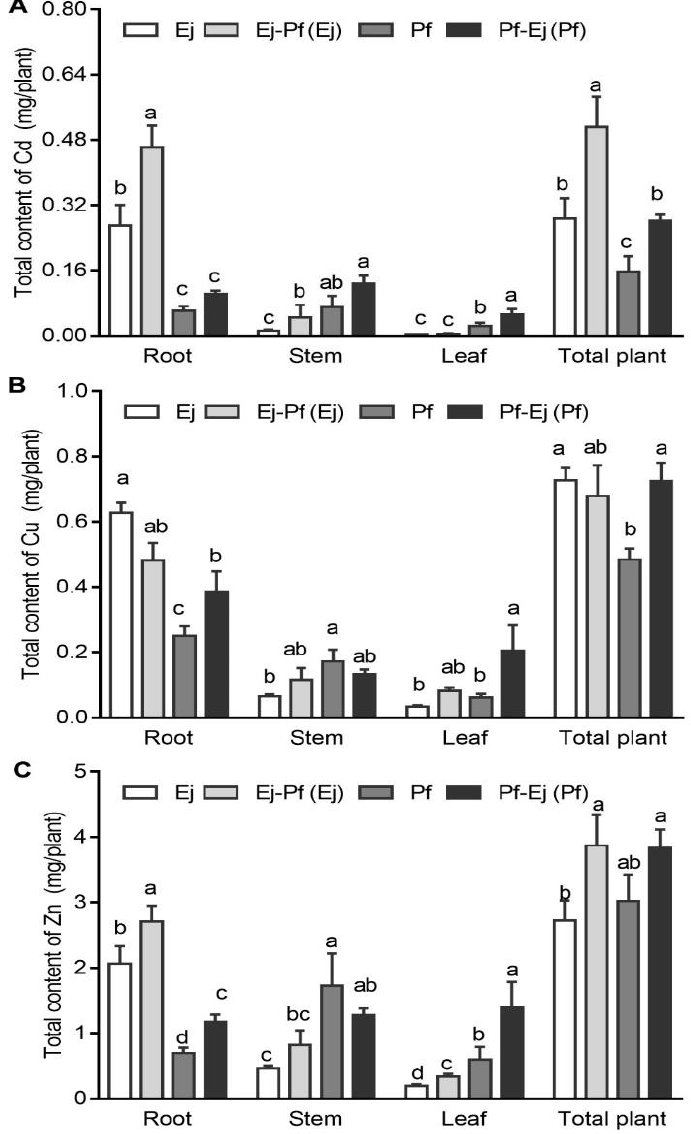
Figure 3. The Cd, Cu, and Zn contents of P. × fraseri and E. japonicus in the monoculture and intercropping systems. Ej and Pf refer to E. japonicus and P. × fraseri in the monoculture system, respectively; Ej-Pf and Pf-Ej (Pf) refer to E. japonicus and P. × fraseri in the intercropping system, respectively. The total contents of Cd ( A ), Cu ( B ), and Zn ( C ) in the root, stem, leaf, and total plant, respectively. All values are presented as the mean ± standard error ( n = 4), and bars with different lowercase letters indicate significant ( p < 0.05) differences between the treatments and control, according to Duncan’s test.